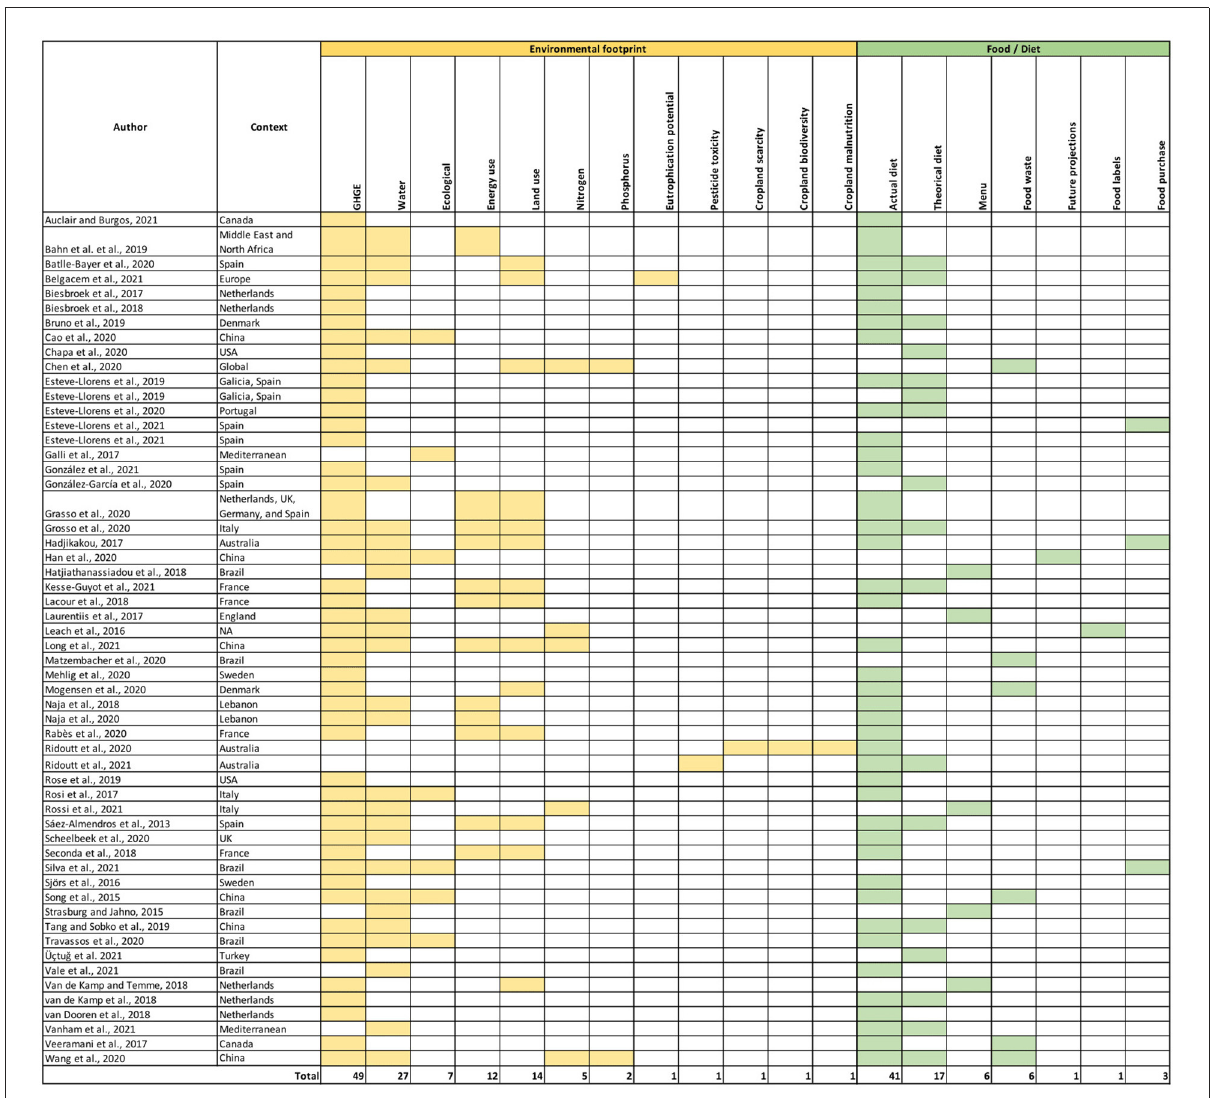
FIGURE6 Summary of the characteristics of the selected studies ( n = 56). GHGE, Greenhouse gas